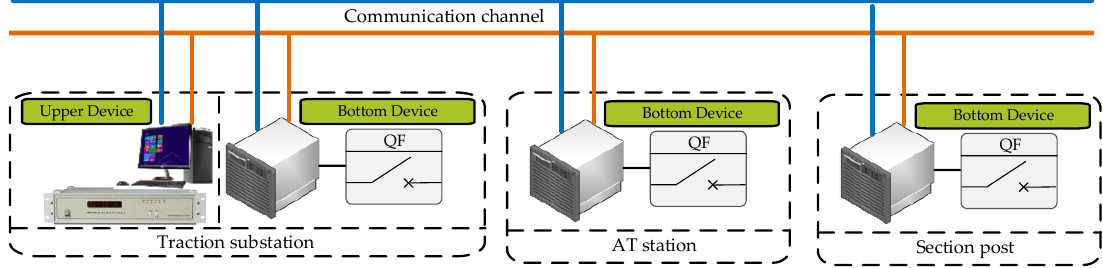
Figure 9. Equipment composition of the protection system for the novel segmental all parallel AT TPSS.